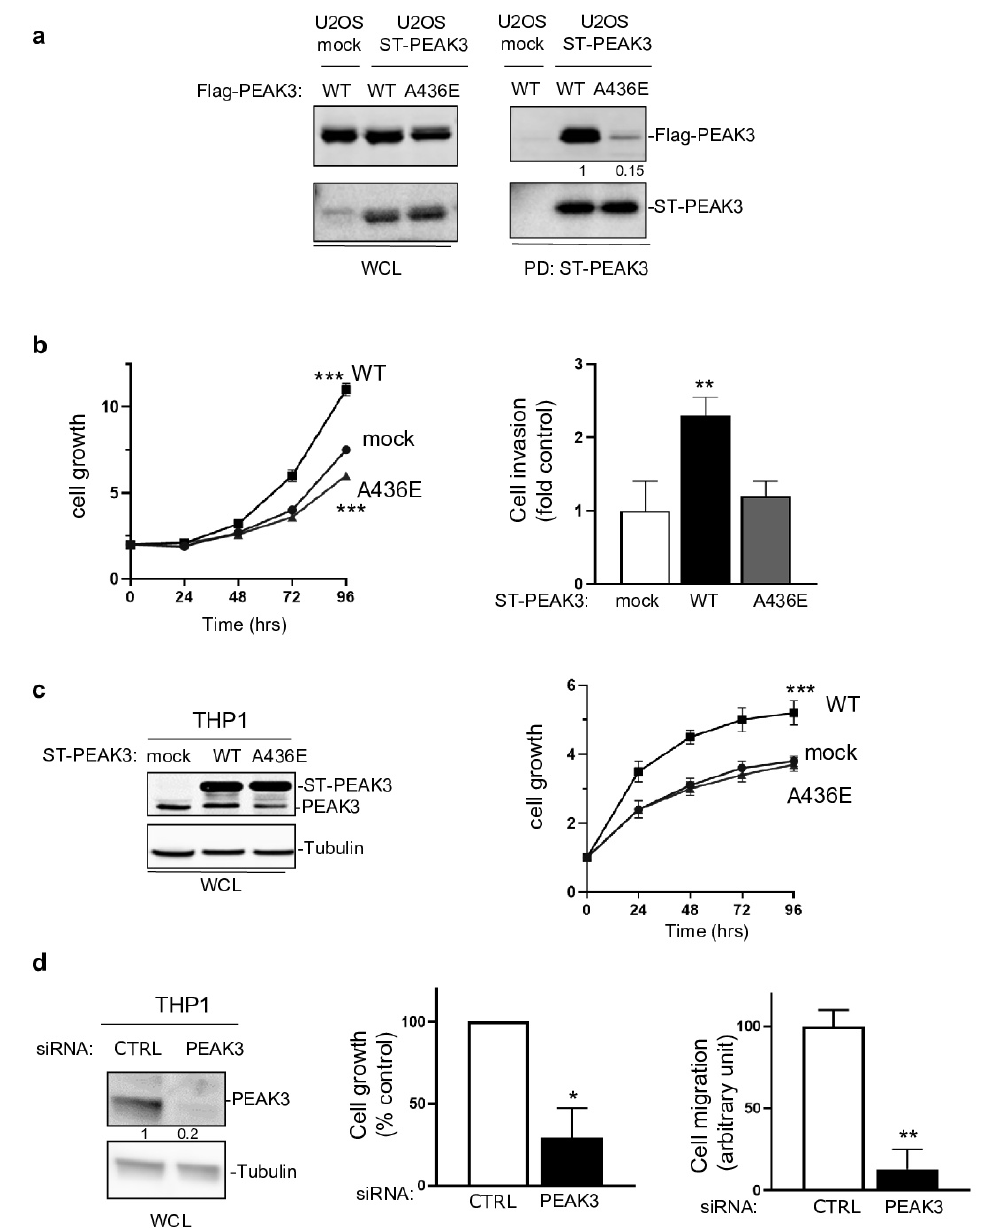
Figure 3. SHED-dependent PEAK3 oncogenic activity. ( a ) SHED-dependent PEAK3 self-association. Co-precipitation of Srep-Tag-PEAK3 (ST-PEAK3) on Strep-Tactin magnetic beads (PD: pull down) with FLAG-PEAK3 and A436E mutant in U2OS cells stably expressing an empty vector (mock) or ST-PEAK3 that were transfected with indicated FLAG-PEAK3 construct. The level of PEAK3 in whole-cell lysates (WCL) is also shown ( n = 2). ( b ) PEAK3 expression promotes U2OS cell growth in a SHED-dependent manner. Cell growth over time (fold vs. control) (left) and cell invasion in Boyden chambers coated with Matrigel (right) in U2OS cells that express the indicated PEAK3 constructs described in panel A (WT: wild type PEAK3; A436E: PEAK3 with an inactive SHED domain). ( c ) ST-PEAK3 level (left) and cell growth over time (fold vs. control) (left) in THP1 cells that express the indicated ST-PEAK3 constructs. ( d ) PEAK3 knockdown (left) reduces THP1 cell growth vs. control cells (cell growth monitored for 3 days) and migration in Boyden chambers coated with an endothelial cell monolayer. Mean ± SD are shown ( n = 3); * p < 0.05; ** p < 0.01 ; ***p < 0.001 (Student’s t test).